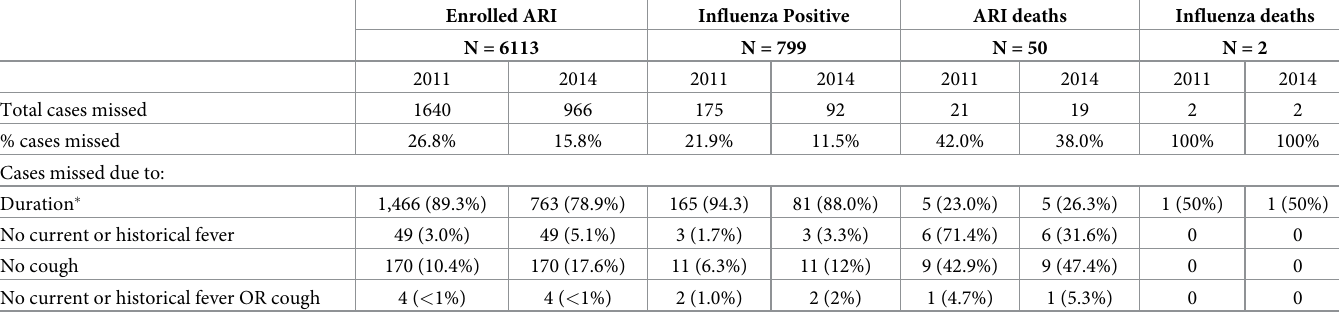
Table 4. Cases missed by the 2011 and 2014 WHO SARI case